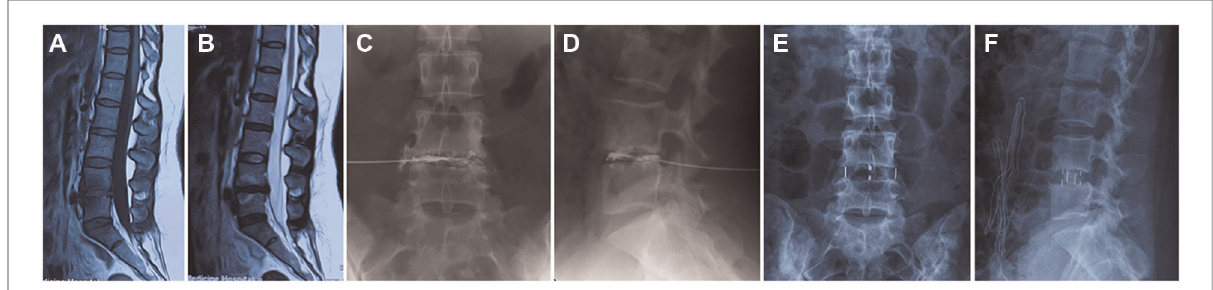
FIGURE 1 Typical case. Type I Modic changes was characterized by low T1 and high T2 signals in MRI on L4-5 endplate ( A,B ). The patient experienced severe LBP and DBP was a de fi nitive diagnosis by discography and discoblock ( C,D ). The patient underwent OLIF stand-alone ( E,F